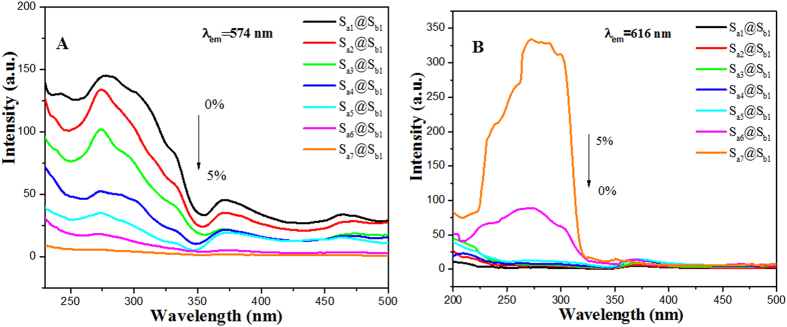
Excitation spectra of samples Sax@Sb1 (x = 1–7) monitored at 574 nm (A) and 616 nm (B).